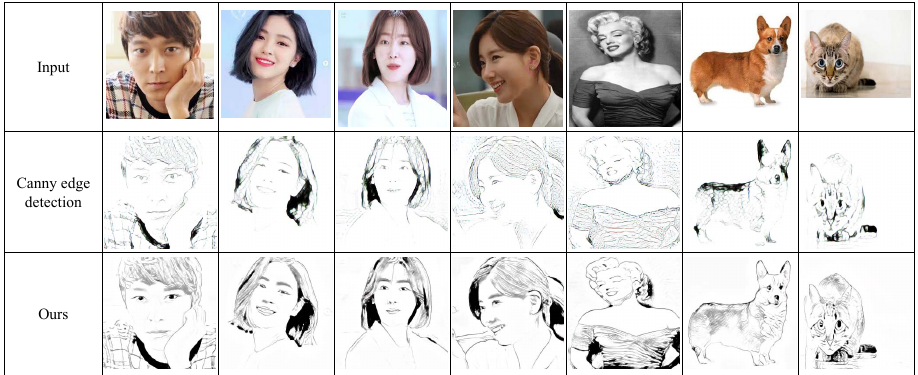
Figure 16. Ablation study on edge extraction